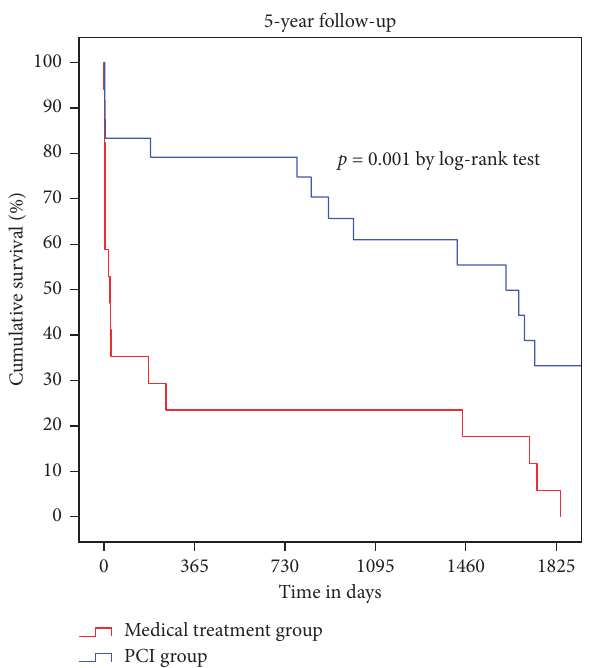
Figure 1: Kaplan–Meier curves of survival in the PCI group and medical treatment group.